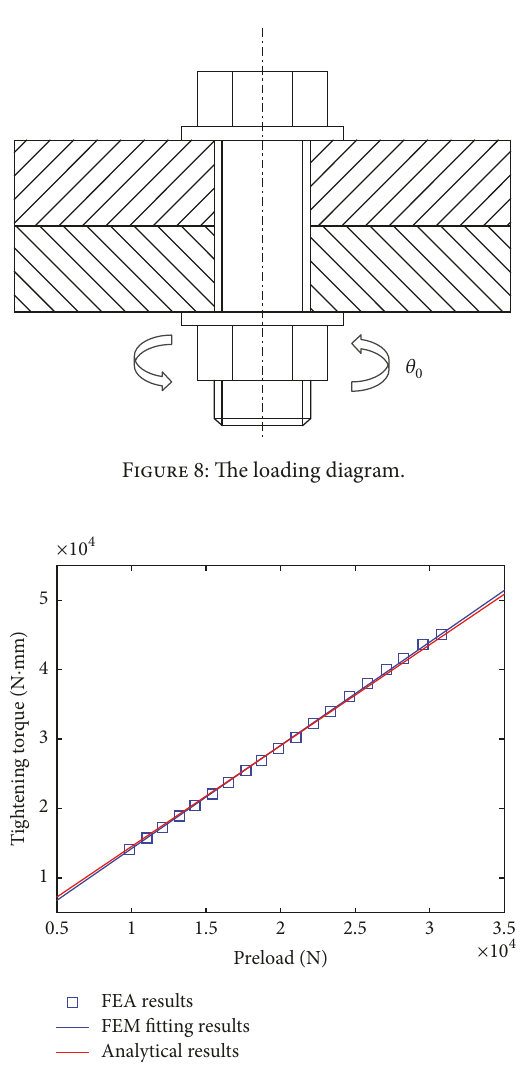
Figure 9: The contrast diagram of torque-tension relationships.